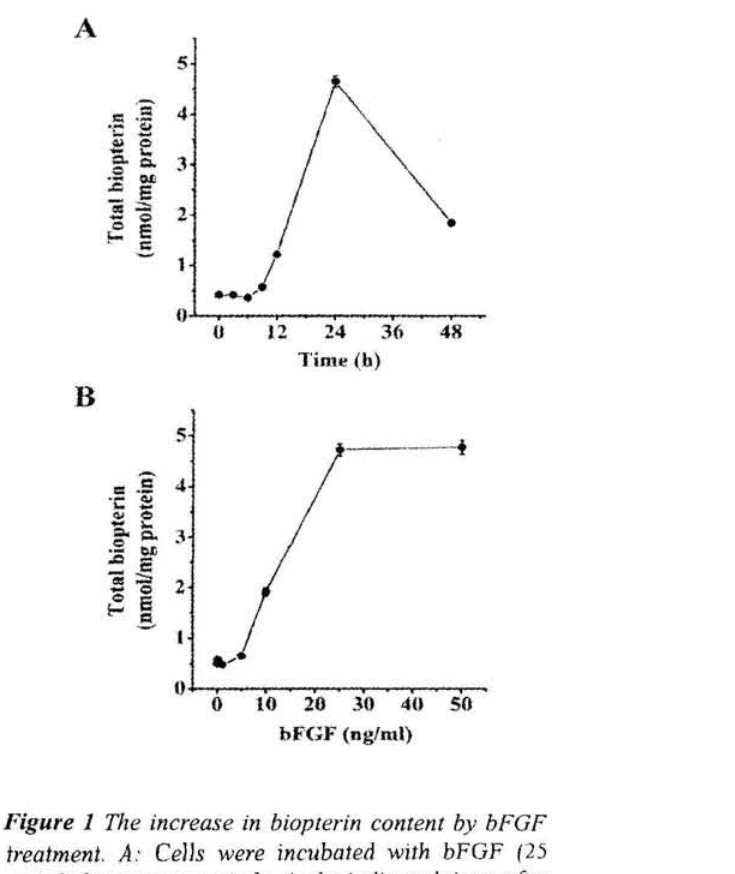
Figure 1 The increase in biopterin content by bFGF treatment. A: Cells were incubated with bFGF (25 ng/ml) for various periods. At the indicated times after the addition of the bFGF, hiopterin determined. B: Cells were incubated with various con- centrations of bFGF (0.1-50 ng/ml) for 24 h. Values are the means ±S.E.M. of 4